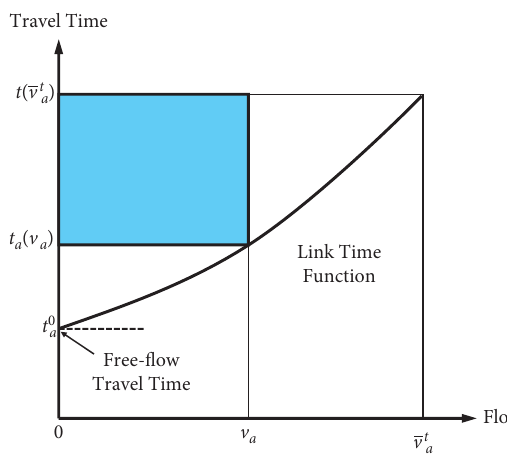
Figure 1: Geometric illustration of the definition of c ( φ )